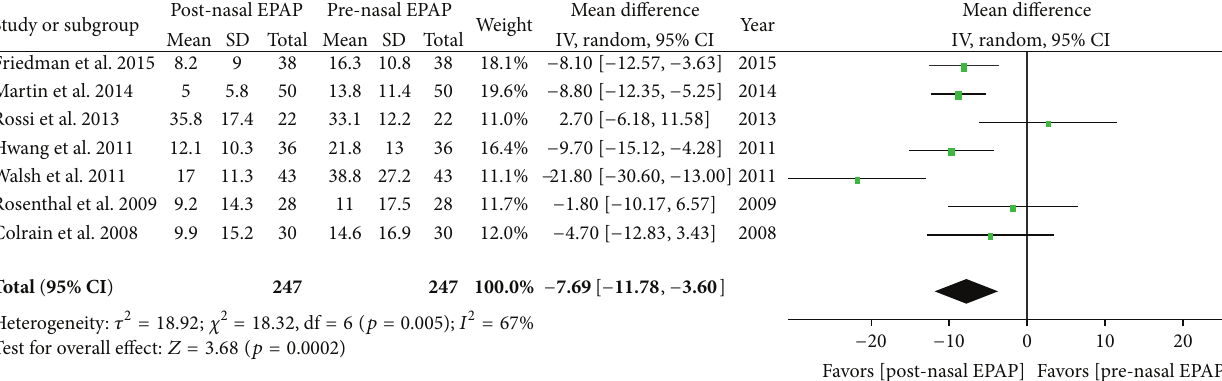
Figure 4: Pre- and post-nasal EPAP therapy outcomes for oxygen desaturation index (events per hour), mean difference. SD: standard deviation; CI: confidence interval; nasal EPAP device: nasal expiratory positive airway pressure device (Provent).